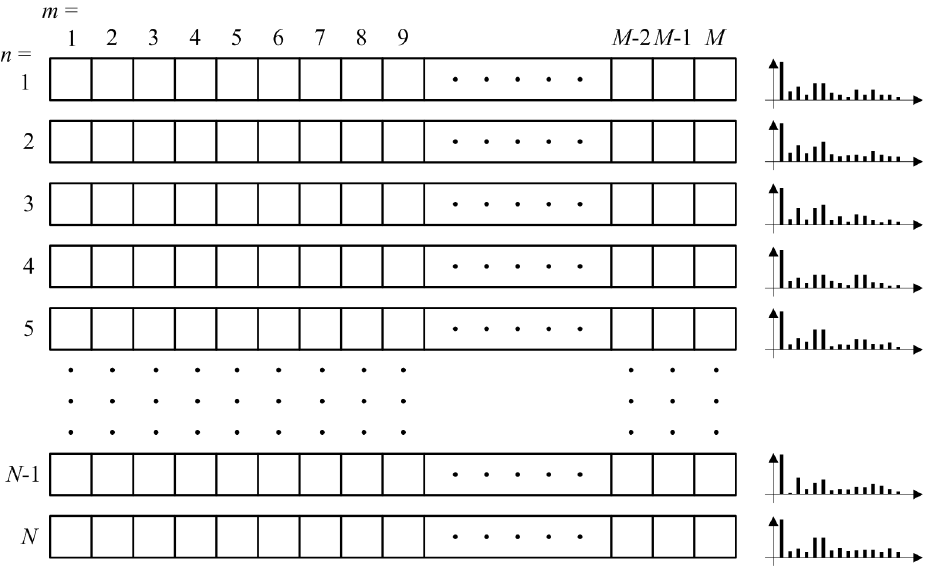
Figure 2. Example of data arrangement for PCA